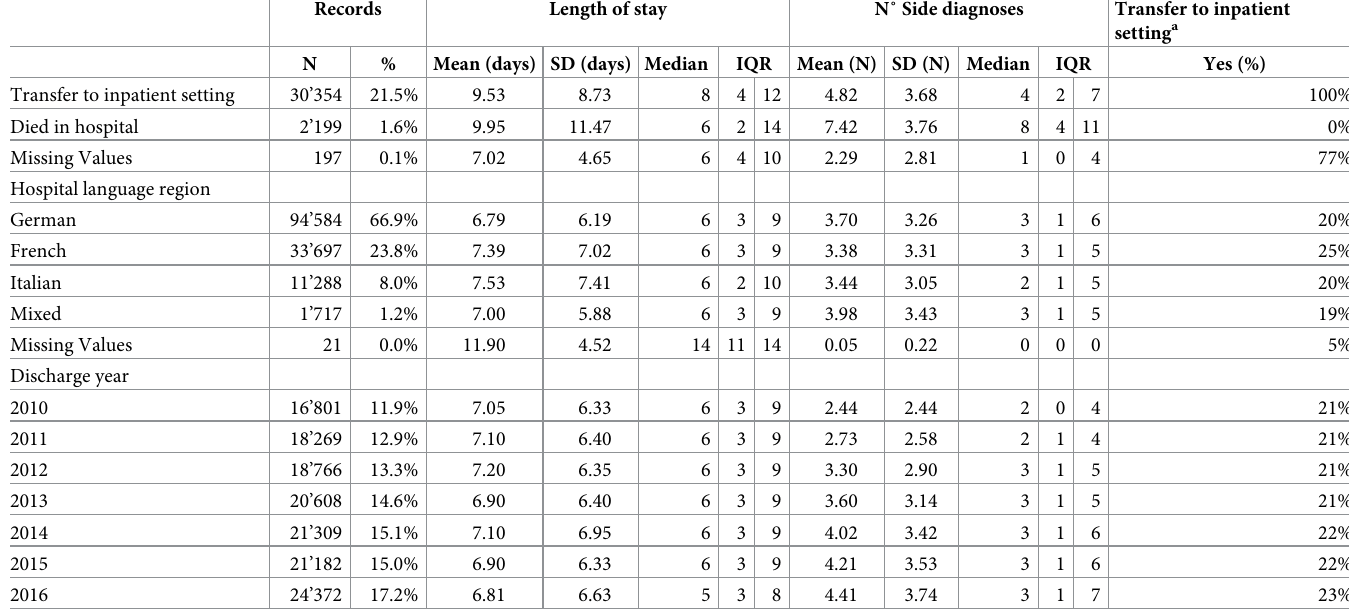
Results of the multilevel linear regression models (Models A-D) are presented in Table 4. Educational attainment . According to Model A, the average length of hospital stay was increased by 0.24 and 0.37 days among patients with upper secondary education and compul- sory education, respectively, compared to patients with tertiary education (both p < 0.001). After adjustment for the two indicators of comorbidity (NSD and psychic comorbidity) the differences collapsed and were no longer significant (Model B). The inclusion of factors related to treatment (Model C) and discharge (Model D) did not further change effect estimates. The tests for interaction in Model D showed evidence for an interaction between educational attainment and main diagnosis (S2 Table). Colon cancer, COPD, asthma and ischaemic heart disease showed significant effects also in the fully adjusted model: Patients with compulsory education stayed significantly longer in hospital compared to those with tertiary education if they had the main diagnosis colon cancer (0.99 days, 95% CI: 0.13, 1.84; p = 0.024) or asthma